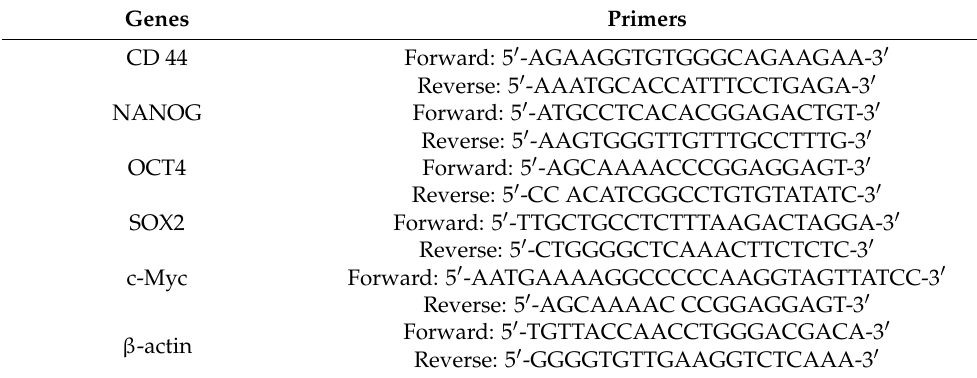
Table 1. Specific Real-time RT-qPCR primers sequences containing human and β -actin